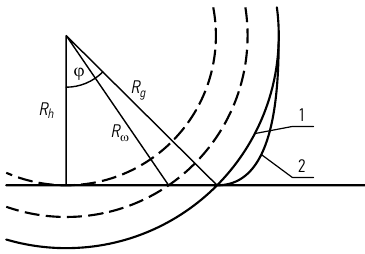
Fig. 6. Tire: 1 – idealized tire profile; 2 – real tire profile